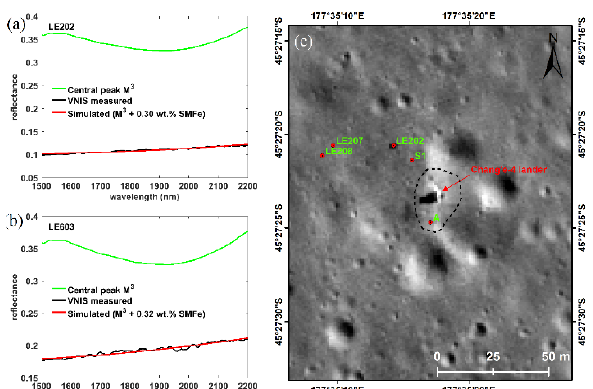
Figure 9. (a)-(b) Hapke model-derived space weathering-induced SMFe abundance at waypoints LE202 and LE603, respectively. (c) The region severely affected by rocket engine plume during soft landing (marked by the black dotted line). The basemap is LROC NAC